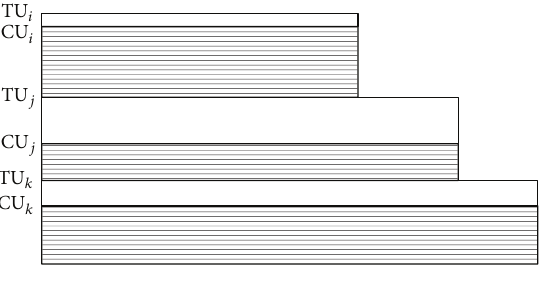
Figure 4: Ideal CPU and ideal execution.